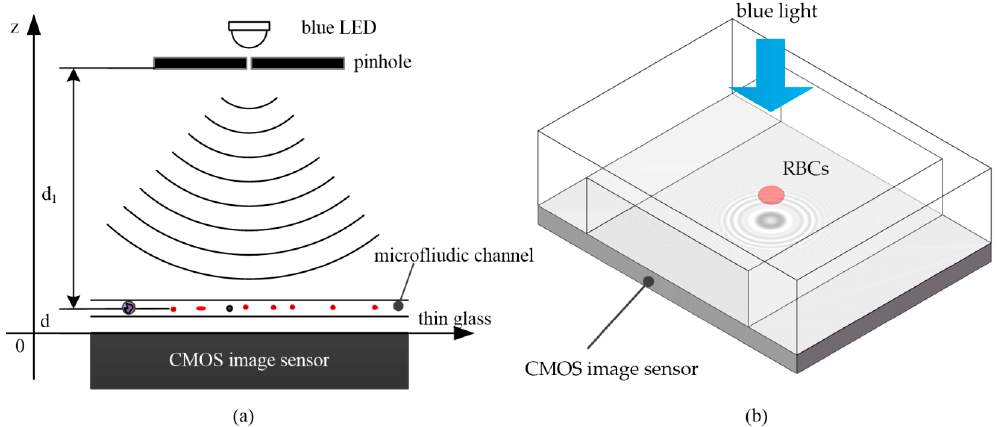
Figure 3. Graphic sketch of an in-line holographic microscope: ( a ) the structure of the lens-less holographic imaging system; ( b ) the procedure for capturing the lens-less hologram by the CIS. Because of the infinitesimal size of blood cells (~2–15 μ m), the shadows of the blood cells on the